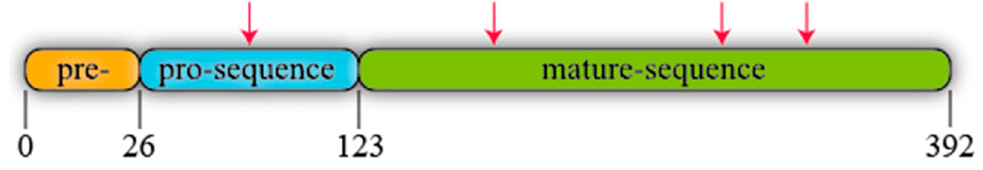
Schematic representation of R. oryzae lipase (ROL). Arrows stand for potential N-glycosylation points.